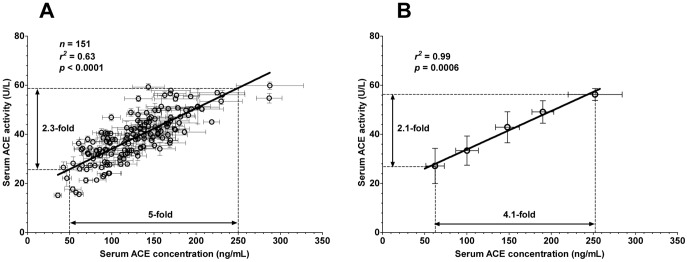
Incomplete correlation between serum ACE concentration and activity.Serum ACE concentration and specific ACE activity was determined in hypertensive patients (n = 151 patients). Serum ACE concentration was determined by an ELISA method using 100-fold diluted serum samples. Human recombinant ACE was used to construct calibration curves for each individual plate. Serum ACE expression was calculated based on these calibration curves. ACE activity was assessed at a 4-fold dilution by measuring the decomposition of the artificial substrate FAPGG. Serum ACE activity is shown as a function of the serum ACE concentration in the figures. Panel A shows the individual data, while patients were grouped according to their serum ACE concentration in panel B. Both graphs were fitted by a linear regression to reveal correlations between the values, and the parameters of the fits are shown. The magnitude of the differences in ACE concentration and ACE activity values are also shown. Symbols represent the mean (measurements were done at least 3-times), bars are SEM.